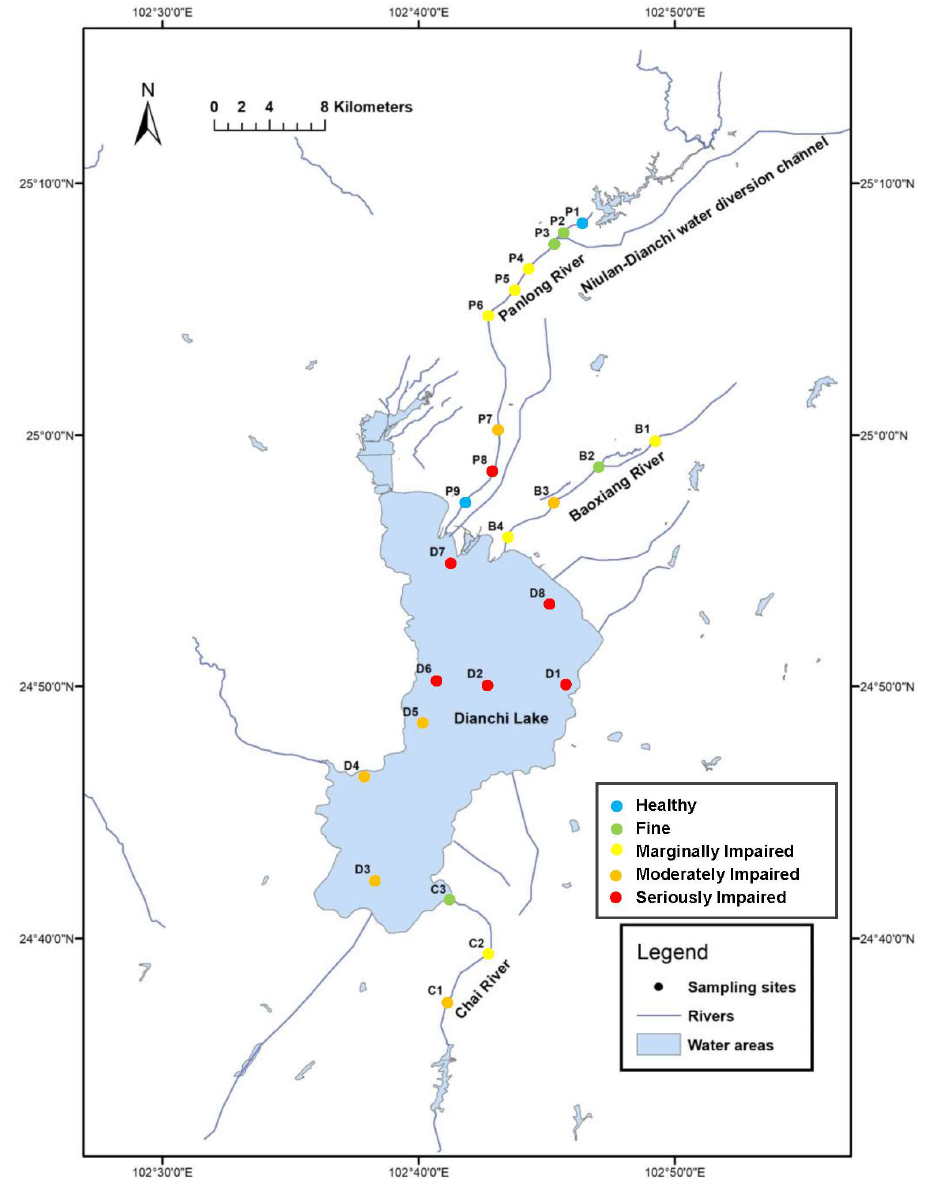
Figure 1. Location of sampling sites in Dianchi Lake and the three inflowing rivers. The colors represent different grades of aquatic ecological condition based on the F-IBI assessment.